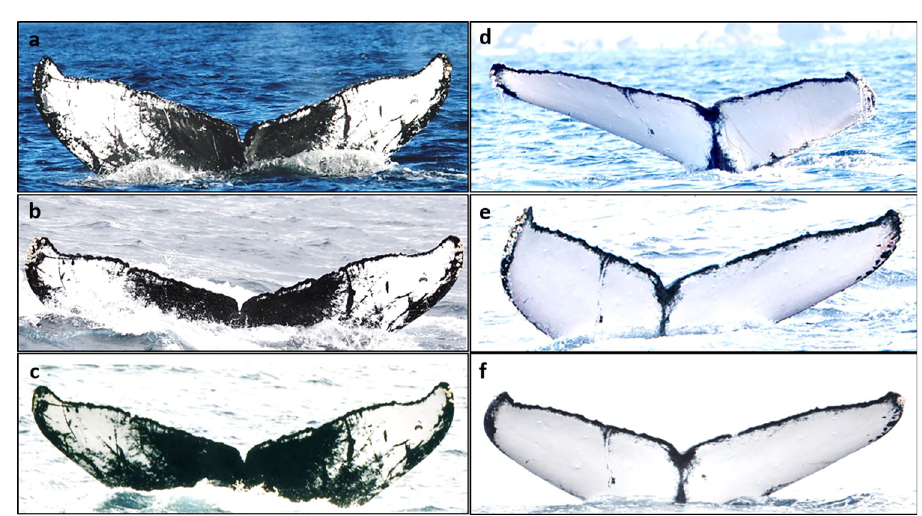
Fig 2. Examples of matched individuals among the three breeding areas in Japan. (a) Individual ‘OG-MN14/O-54’ observed in Ogasawara. (b) The same individual, ‘A-157,’ observed in Amami, and (c) ‘R-7,’ also the same individual, observed in Okinawa. (d) Individual ‘O-5’ observed in Ogasawara. © Same individual, ‘A-171,’ observed in Amami, and (f) ‘R-467’ also the same individual observed in Okinawa. The fluke images are published from PLOS ONE under a CC BY license, with permissions from Ogasawara Whale Watching Association for image (a), Everlasting nature of Asia for image (a), and (d), Amami Whale and Dolphin Association for images (b), and © , and Okinawa Churashima Research Center for images (c), and (f), all original copyright